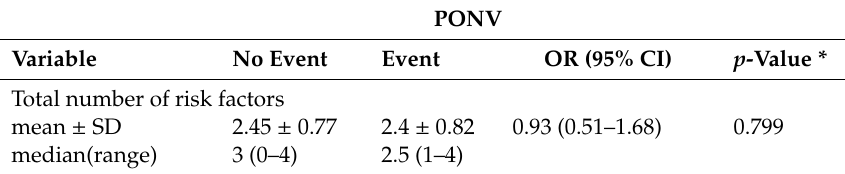
Table 7. PONV risk factors associated with PONV and nefopam.